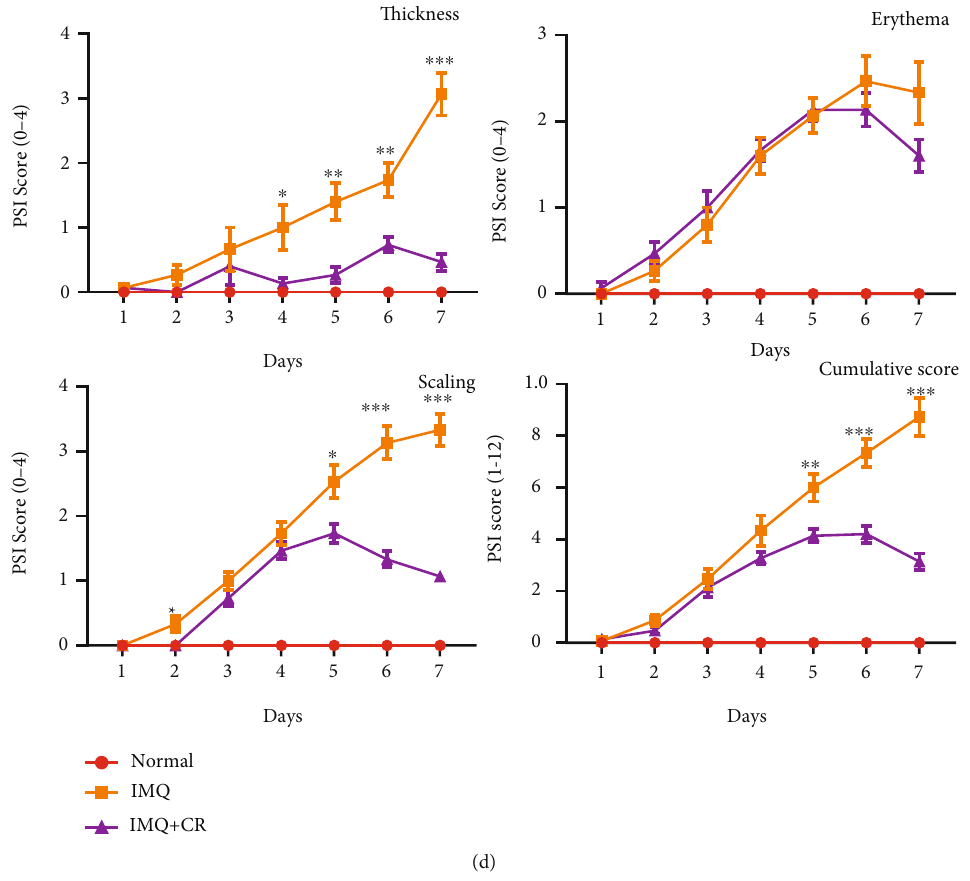
Figure 1: CR treatment attenuated the severity of IMQ-induced PsD in mice. (a) The scheme of IMQ-induced murine model and CR treatment. Clinical presentation of mice (b) and dermoscopic presentation ( scale bar = 1 mm ) (c) of the back skin of mice after 7 days of IMQ treatment with or without the topical application CR. (d) The daily scores of erythema, skin thickness, scaling of back skin, and PSI scores were compared among normal group ( n = 11 ), IMQ group ( n = 15 ), and IMQ+CR group ( n = 15 ). Data are shown as the Mean mean ± SEM and were analyzed by using t -test. ∗ P < 0 : 05, ∗∗ P < 0 : 01, and ∗∗∗ P < 0 : 001 , showing the di ff erence between the IMQ group and IMQ+CR